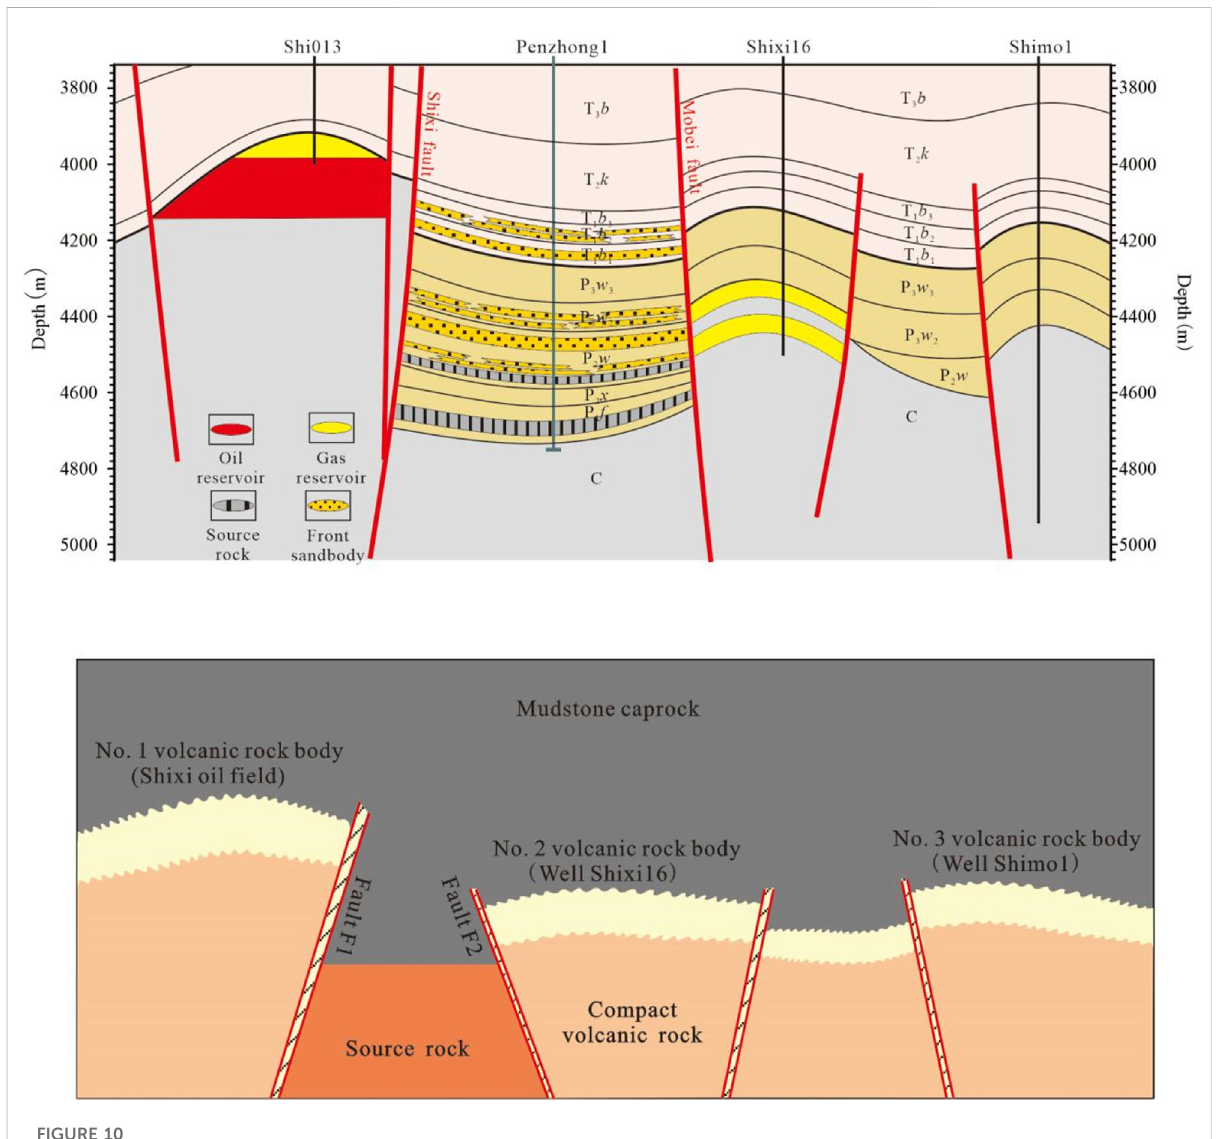
FIGURE 10 Geological model of oil – gas migration and